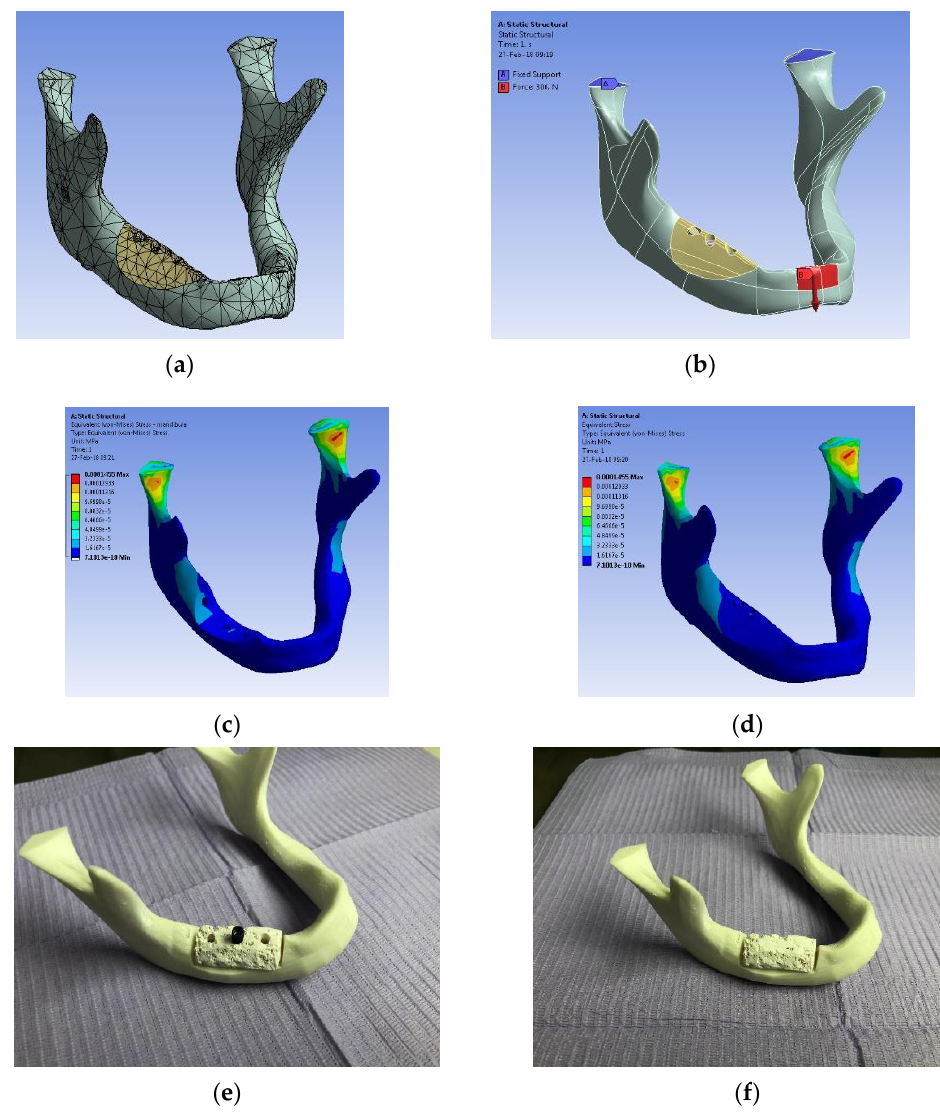
Figure 11. ( a ) Example of an application of ceramic scaffolds such as those that were developed in the present study: FEA performed on a mandible, with ( a ) the design of the mesh, ( b ) application of forces, FEA without ( c ) and with ( d ) the mounted scaffold; physical realization of the assembly, with three ( e ) or with two ( f ) implants — from the detailed study in [24].